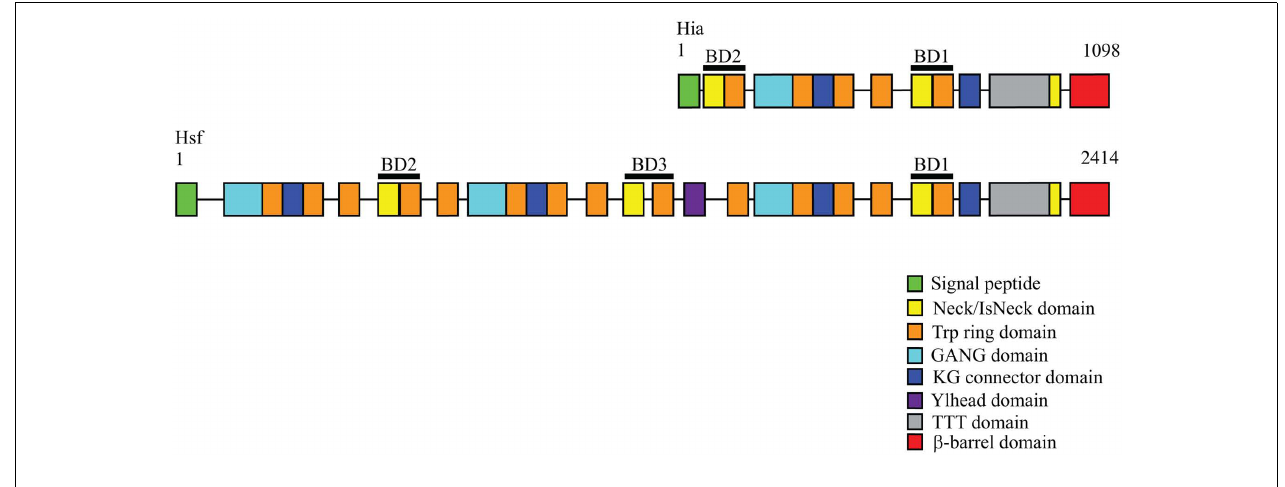
extended domain arrangement compared to Hia. Domain arrangements were obtained from the daTAA server (http://toolkit.tuebingen.mpg.de/